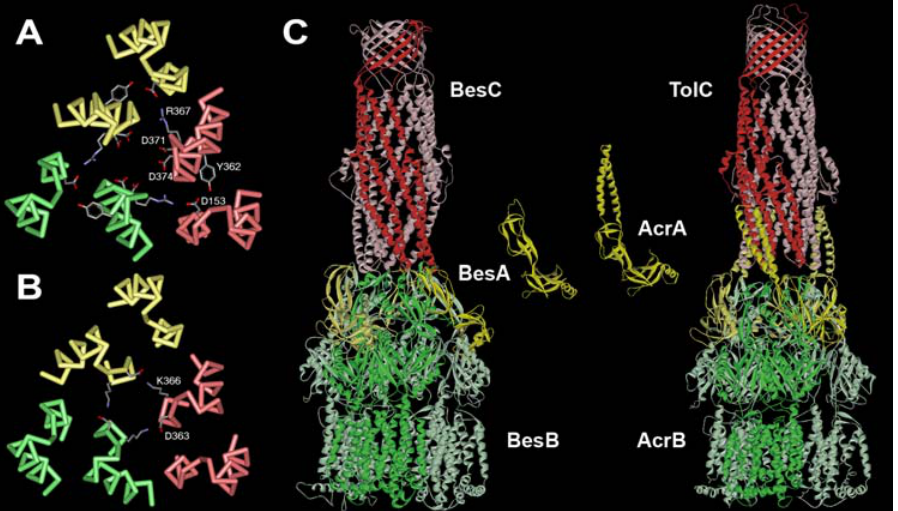
Figure 4. Comparison of the periplasmic tunnel entrance of E.coli TolC with the modeled structure of Borrelia BesC and a model of the Borrelia efflux pump. The backbone of the peptide chains of the three monomers are colored differently. Side chains are omitted except those lining the tunnel entrance. These are D371 and D374 in TolC (A) and D363 and K366 in BesC (B) or those involved in forming the circular network in TolC - D153, Y362, and R367. (C) The channel-tunnel BesC is colored red, the adaptor protein BesA is shown in yellow and the RND transporter in green. Structures of all three components are modeled and formed according to existing models [28,82,83]. The model of the adaptor protein BesA shows just residues 38–219 of the mature chain. The remaining parts of the protein are not modeled because of the missing template. In this model the complex is comprised of three adaptor protein protomers. It should be mentioned that there are other models proposed suggesting six adaptor protein protomers per efflux apparatus [31,59]. Note that the adaptor proteins do not have the alpha-helical domain, which is thought to interact with the helices of the tunnel region of the outer membrane component in other bacterial efflux pumps.